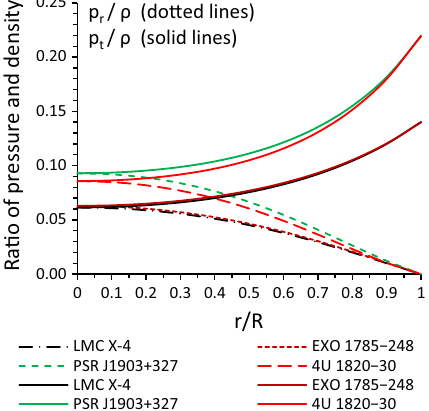
Fig. 3 Behaviour of anisotropy factor (cid:9) vs. fractional radius r / R for LMC X-4, EXO 1785-248, PSR J1903+327 and 4U 1820-30. For plot- ting this figure we have employed data set values of physical parameters and constants as used in Figs. 1 and 2